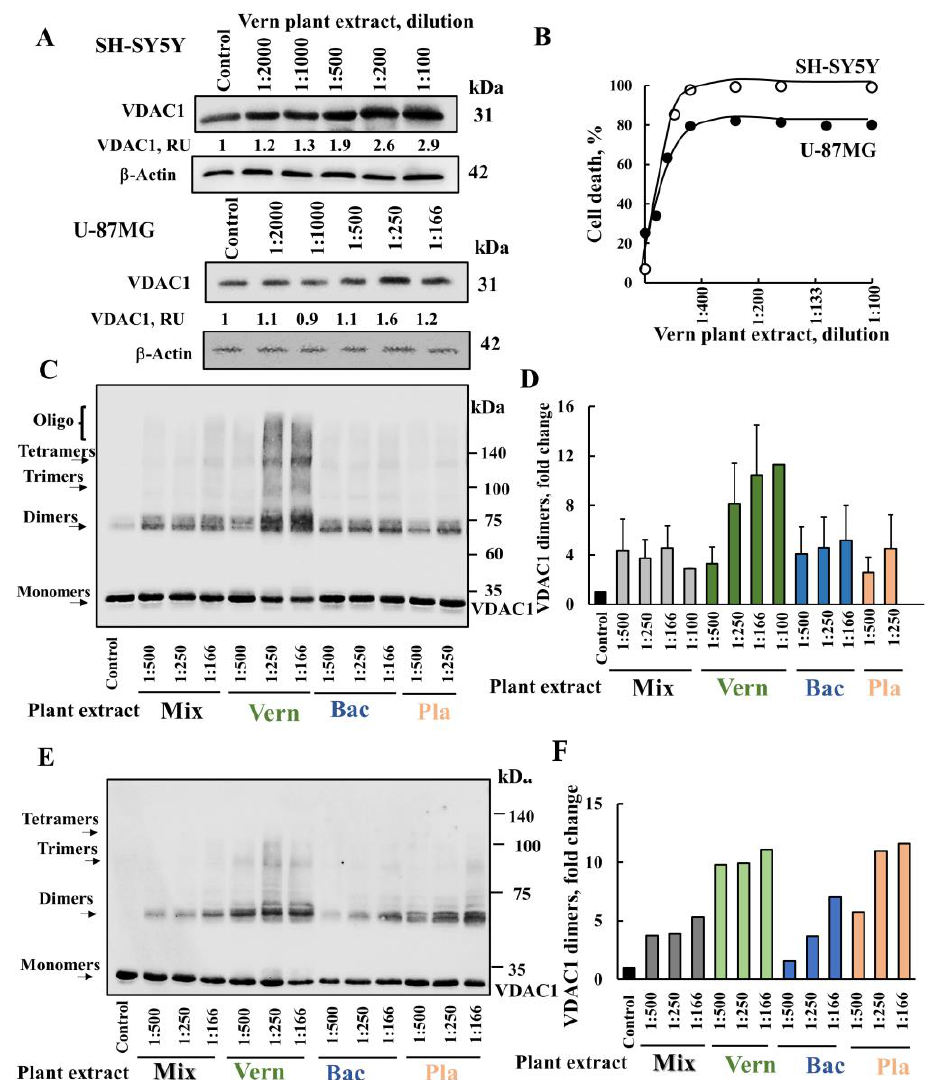
Figure 2. Vern plant extract induced VDAC1 overexpression, oligomerization, and cell death . ( A,B ) SH-SY5Y or U-87MG cells were incubated for 24 h with the indicated dilution of Vern plant extract, and then analyzed for VDAC1 expression levels ( A ) by immunoblotting using anti-VDAC1- specific antibodies. Immunoblotting with β -actin as a loading control is also shown. The levels of VDAC1 are given below the blot as relative units (RUs). Samples were also analyzed for cell death ( B ). ( C , D ) SH-SY5Y cells (1 mg/mL) were incubated for 24 h with the indicated dilutions of extracts Vern, Bac, Pla, or their mixture and then analyzed for VDAC1 oligomerization by incubation with the cross-linking reagent EGS (100 μM), followed by immunoblotting using anti-VDAC1 antibodies ( C ). The positions of the VDAC1 monomers, dimers, trimers, tetramers, and higher oligomers are indicated. The level of VDAC1 dimers was analyzed using FUSION-FX software ( D ) and presented relative to its levels in control cells subjected to EGS. ( E , F ) SH-SY5Y cells were incubated for 24 h with the indicated dilutions of plant extracts Vern, Bac, Pla, or their mixture without EGS treatment, and subjected to immunoblotting. The position of the VDAC1 monomers, dimers, trimers, and tetramers is indicated. The level of VDAC1 dimers was analyzed using FUSION-FX software and presented relative to its levels in control cells ( F ).